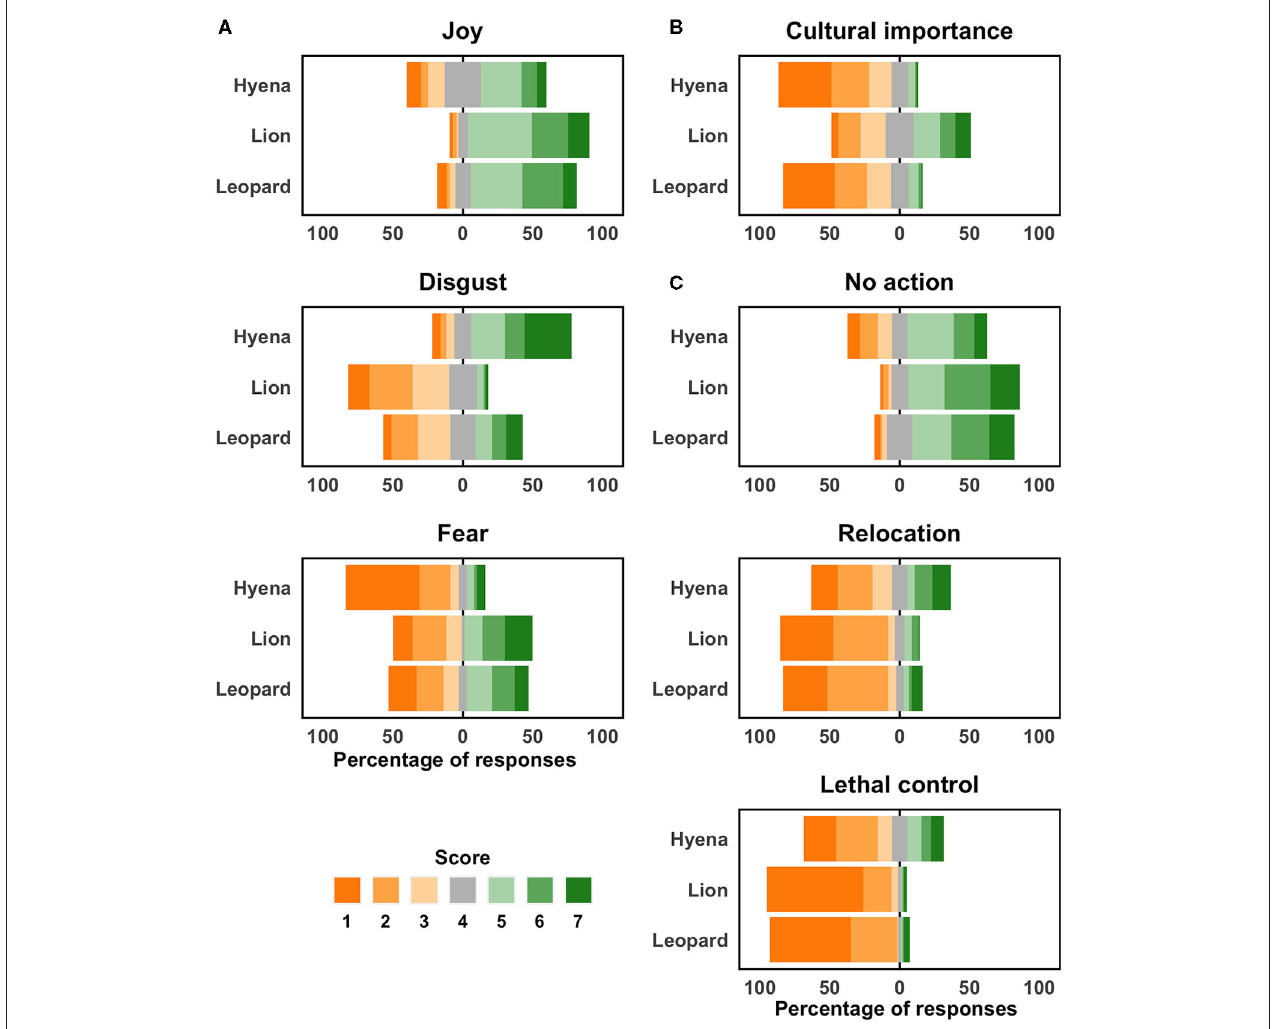
FIGURE 2 | Distribution of scores (percentage of responses) for the emotions joy, disgust, and fear (A) , cultural importance (B) , and the acceptance of the management strategies no action, relocation, and lethal control (C) toward hyenas, lions, and leopards by Maasai pastoralists in Ngorongoro Conservation Area, Tanzania. Data correspond to scores on a seven-point scale in questionnaires ( n = 100). Diverging stacked bar plots display the distribution of scores ranging from 1 (strongly disagree/reject) to 7 (strongly agree/accept), with 4 representing a neutral score. The left side (orange range) of the figure shows the percentage in disagreement and the right side (green range) the percentage in agreement with the